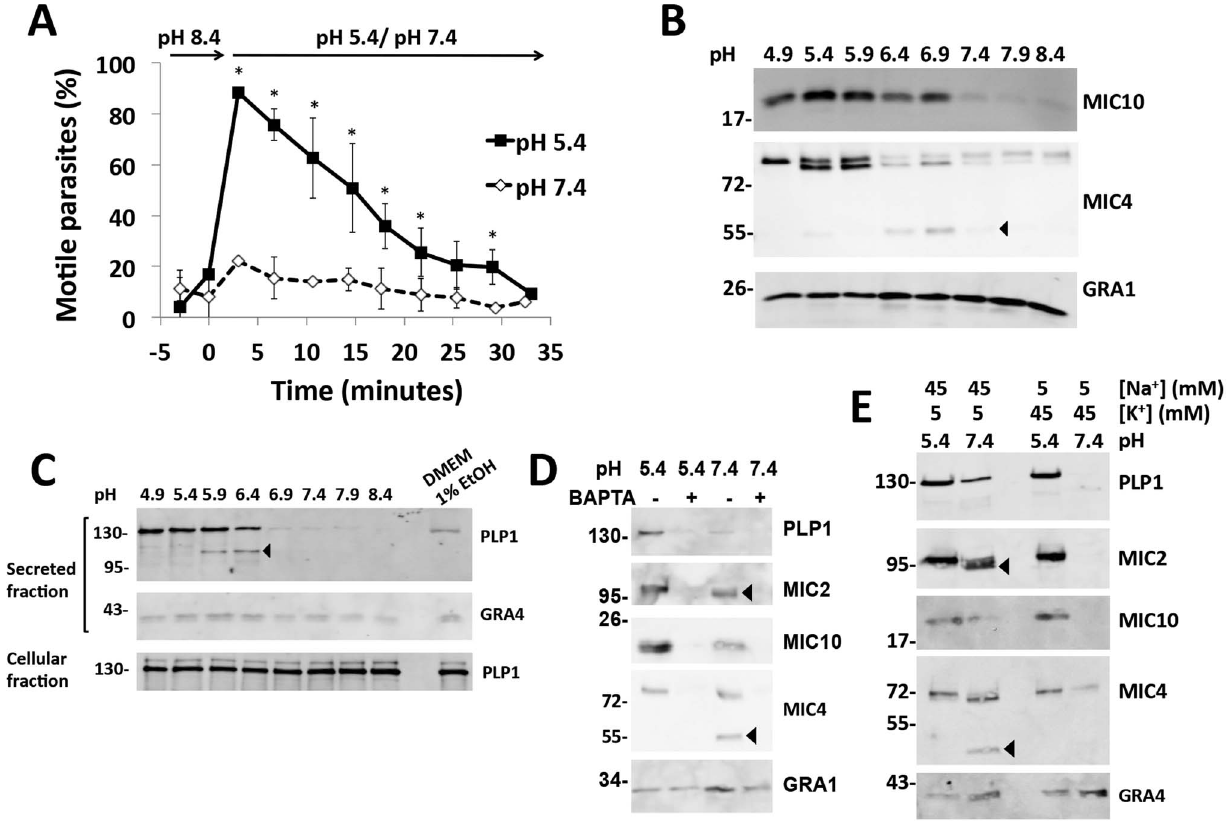
Figure 1. Low pH promotes parasite motility and microneme secretion. (A) Videomicroscopy analysis of pH dependent parasite motility. Parasites were purified in high K + buffer (pH 8.4) and analyzed before and after exchanging to the same buffer at pH 7.4 or 5.4. Graph indicates the average and standard deviation of 3 independent experiments. * p , 0.05 vs. pH 7.4 by student’s t -test. (B) Immunoblot analysis of pH dependent microneme secretion. Parasites were purified in Endo buffer and switched to Endo buffer of the indicated pH, incubated for 2 min at 37 u C and placed on ice. Blots of secreted material were probed with antibodies for MIC10, MIC4 or GRA1 as indicated. (C) Low pH induces more microneme secretion than ethanol stimulation and PLP1 is secreted and processed in a pH-dependent manner. Blots of secreted material were probed with antibodies for PLP1 and GRA4 as indicted. Also shown is a blot of PLP1 from cell pellets (cellular fraction) obtained by centrifugation after secretion. (D) Low-pH induced microneme secretion is blocked by the Ca 2 + chelator, BAPTA-AM, as observed by immunoblot of PLP1, MIC2, MIC10, and MIC4. GRA1 secretion is not affected by BAPTA-AM. (E) Low pH induces microneme secretion in the presence of high K + concentration. Arrowheads for panels B, D and E indicate products of SUB1